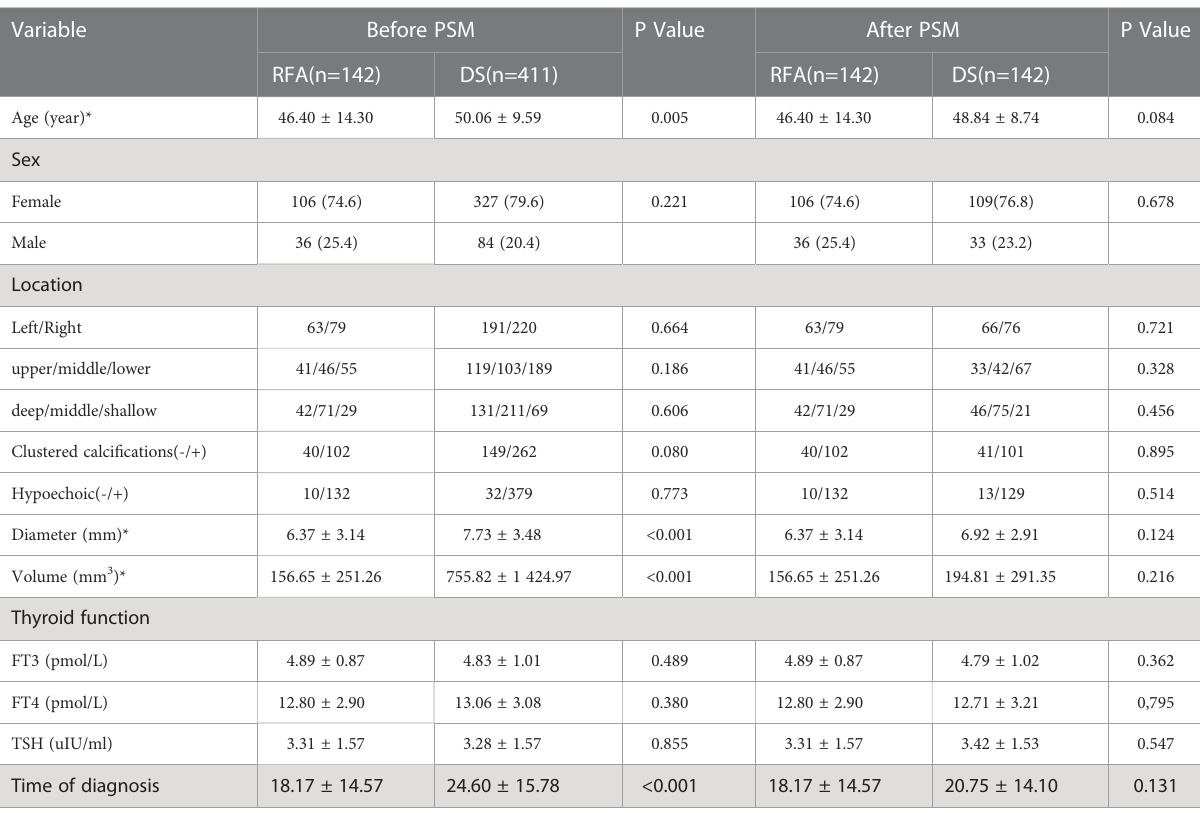
reduction was minimal after 24 months, which has shown in Figure 2. The tumor disappearance rate was 53.5% (76/142). The American Joint Committee classi fi es the T1 PTC into T1a (tumor ≤ 1 cm) and T1b (tumor > 1 cm but ≤ 2 cm). The follow-up data for T1a and T1b PTC are shown in Table 3. The MD and V of T1a of the ablation zone at the 12-month follow-up were less than those for the original tumor (P < 0.001 for both). The changes of MD and V in T1b PTC at the 12-month follow-up were signi fi cant (P = 0.003 and P = 0.004, respectively).